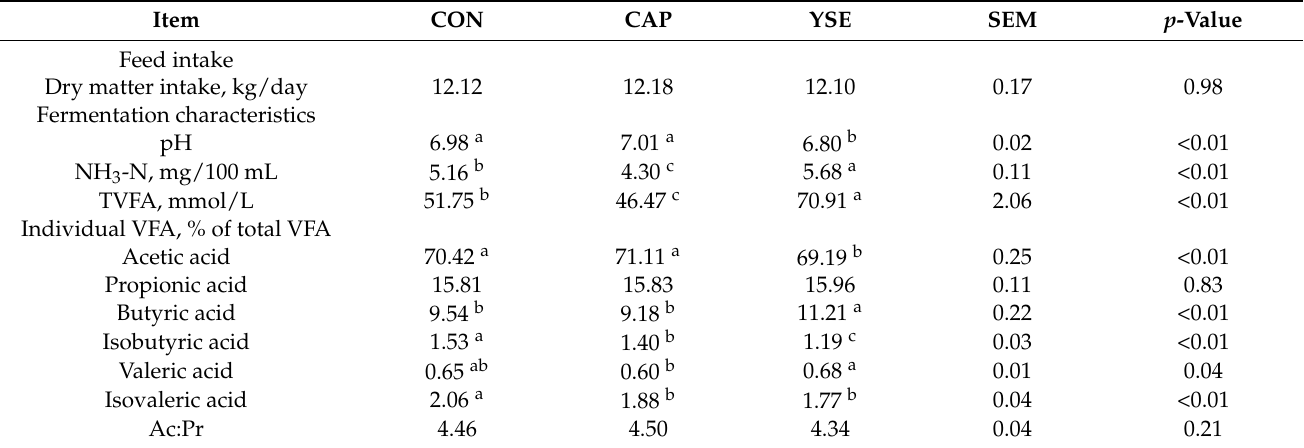
Table 2. Feed intake and rumen fermentation parameters of Angus steers fed with different